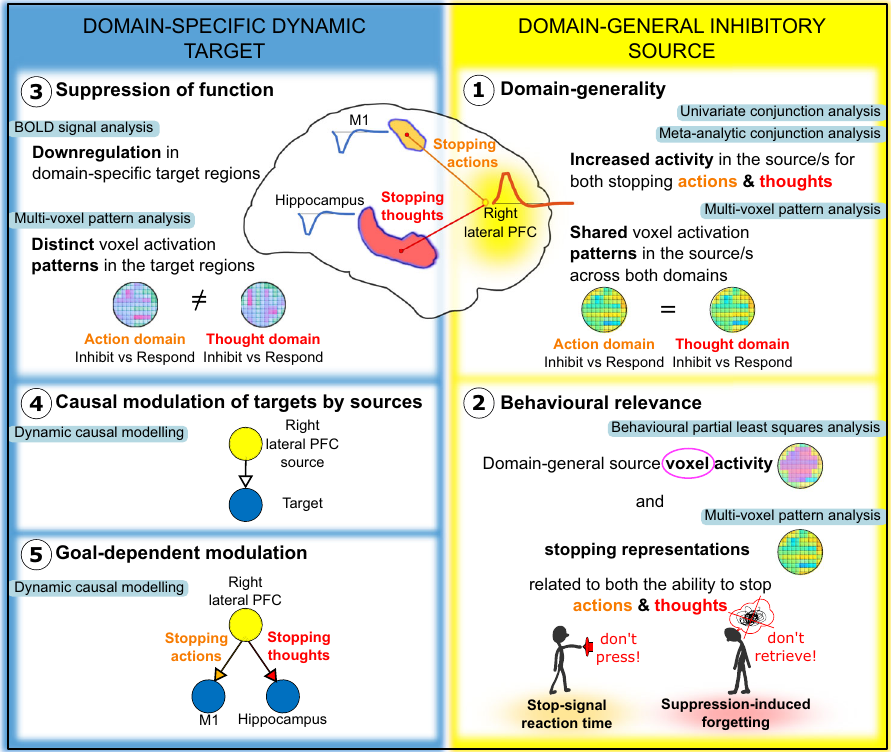
Fig. 1 The fi ve attributes of dynamic targeting. Schematic of the fi ve attributes of domain-general inhibitory control by dynamic targeting and methods employed (teal colour boxes) to test the attributes. Attributes 1 – 2 relate to the existence of domain-general inhibitory sources. The predicted location of such sources was in the right lateral PFC. We present the two attributes on the right side to match the visualised location of the expected sources. To test the domain-generality of inhibitory sources (attribute 1), we performed univariate and meta-analytic conjunction analysis of the No-Think > Think and Stop > Go contrasts, and cross-task multi-voxel pattern analysis (MVPA). To test the behavioural relevance (attribute 2), we related inhibitory activations within the identi fi ed domain-general regions to individual variation in inhibition ability (stop-signal reaction time and suppression-induced forgetting) using behavioural partial-least squares and MVPA. Attributes 3 – 5 relate to the existence of domain-speci fi c target sites that are dynamically modulated by the domain-general sources. Our a priori assumption was that suppressing actions and thoughts would target M1 and hippocampus, respectively. To test the suppression of function within the target sites (attribute 3) we performed a region of interest (ROI) analysis expecting down-regulation within the target sites, and cross-task MPVA expecting distinct activity patterns across the two task domains. To test whether the prefrontal domain-general sources exert top-down modulation of the target sites (attribute 4) dynamically targeting M1 or the hippocampus depending on the process being stopped (attribute 5), we performed dynamic causal